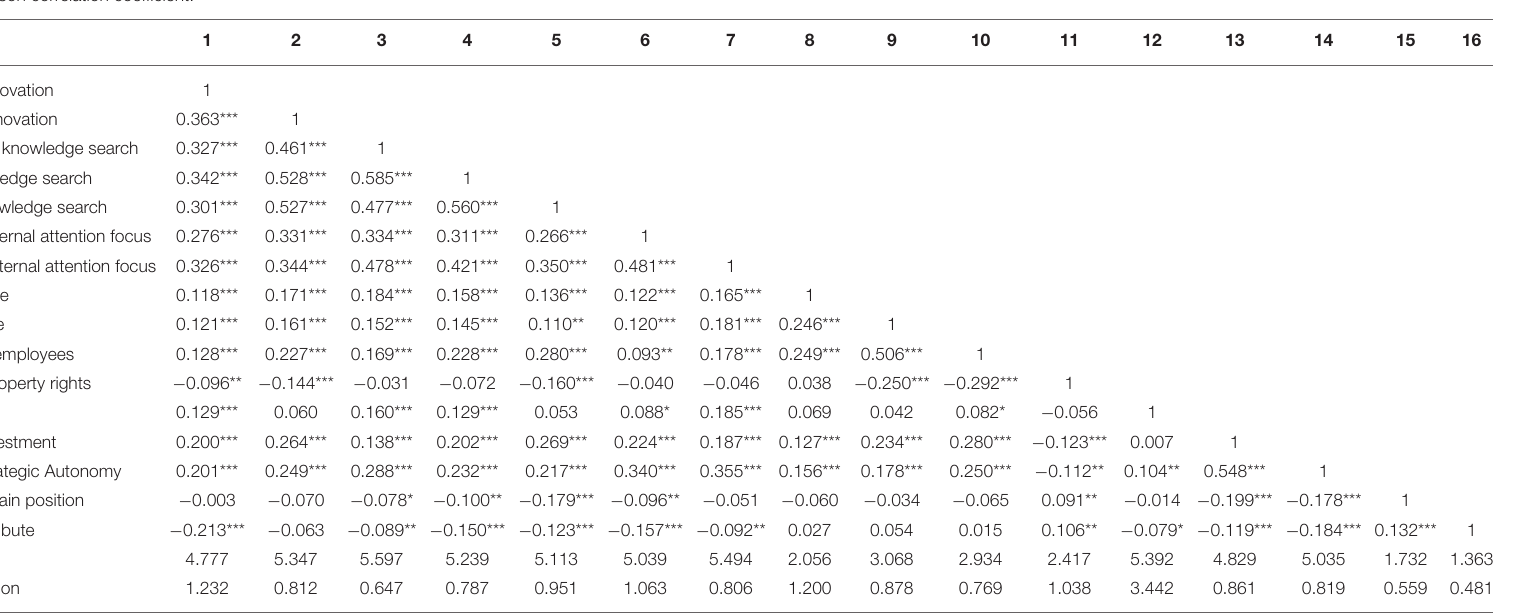
TABLE 4 | Pearson correlation